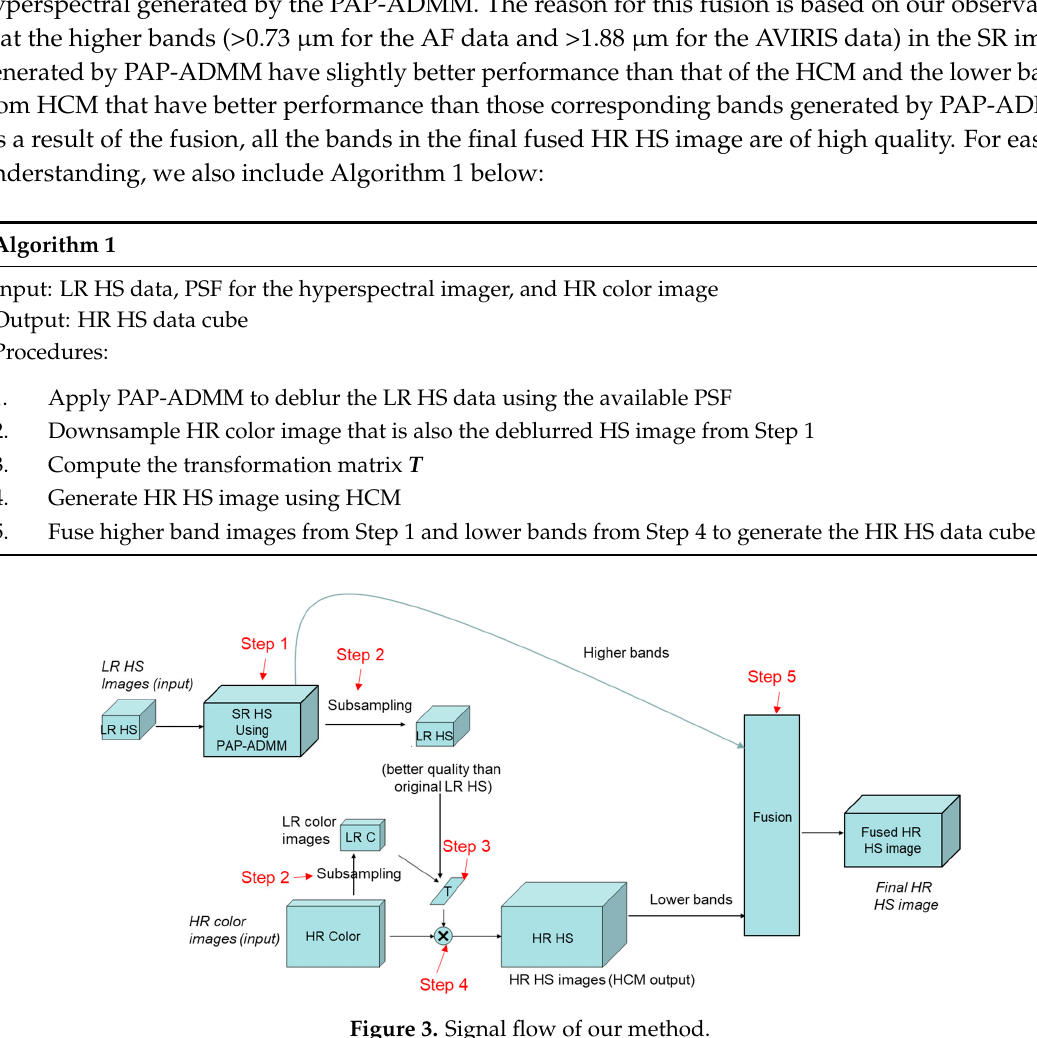
Figure 3. Signal flow of our method.